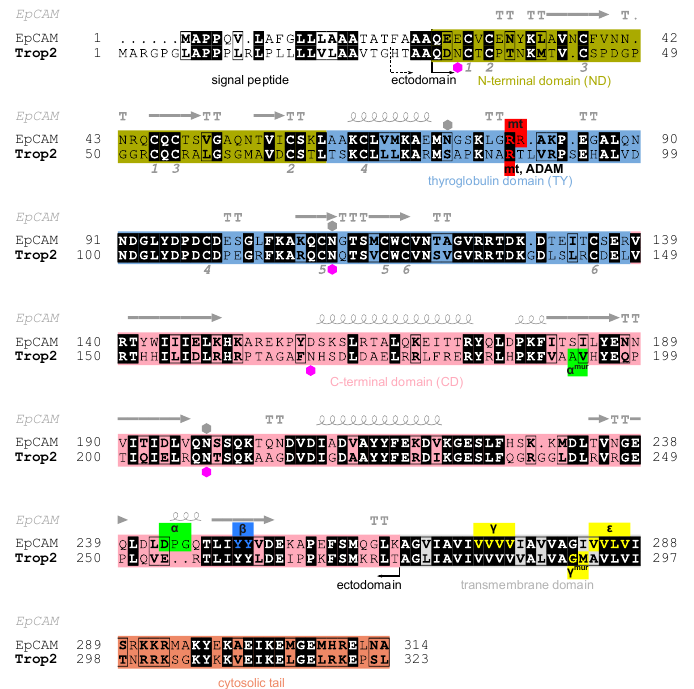
Figure 1. Alignment of human Trop2 (UniProt P09758-1) and EpCAM (UniProt P16422-1) amino acid sequences with marked N-terminal (olive), thyroglobulin (light blue), C-terminal (pink), transmembrane (grey) and cytosolic (orange) regions/domains. Identical residues are shown in bold and with black background, and chemically similar residues in bold and in rectangles. Hexagons denote N-glycosylation sites as annotated in UniProt for Trop2 (magenta) and EpCAM (grey). Pairs of cysteine residues forming a disulfide bridge are denoted by equal numbers below the alignment (from one to six, corresponding to six disulfide bridges). Secondary structure elements in EpCAM (PDB ID 4MZV [6]) are shown above EpCAM sequence: α -helices (spiral), β -strands (arrows), α -turns (TTT) and β -turns (TT). Smaller red, green, blue and yellow boxes denote experimentally determined proteolytic cleavage sites on human Trop2 and EpCAM, by matriptase (mt), TACE ( α ), ADAM10 (ADAM), β -secretase 1 (BACE, β ) and γ -secretase ( γ , ε ). Cleavage sites determined using a murine protein are denoted by “mur” superscript; the corresponding residues in human protein were deduced from alignment of murine and human sequences. Two alternative N-termini of the ectodomain are marked: H27 (currently annotated in UniProt) and Q31 (predicted using SignalP [25]). Figure was prepared using ESPript 3.0 [26], and the output has been manually edited to include features and topological